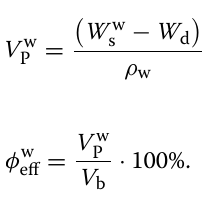
Porosity from log interpretation (Archie‑porosity) For correlation and validation of the measured porosity data, porosity of a geothermal well near Munich using the deep elec- tric resistivity reading of a downhole log was calculated by Eq. (8) proposed by